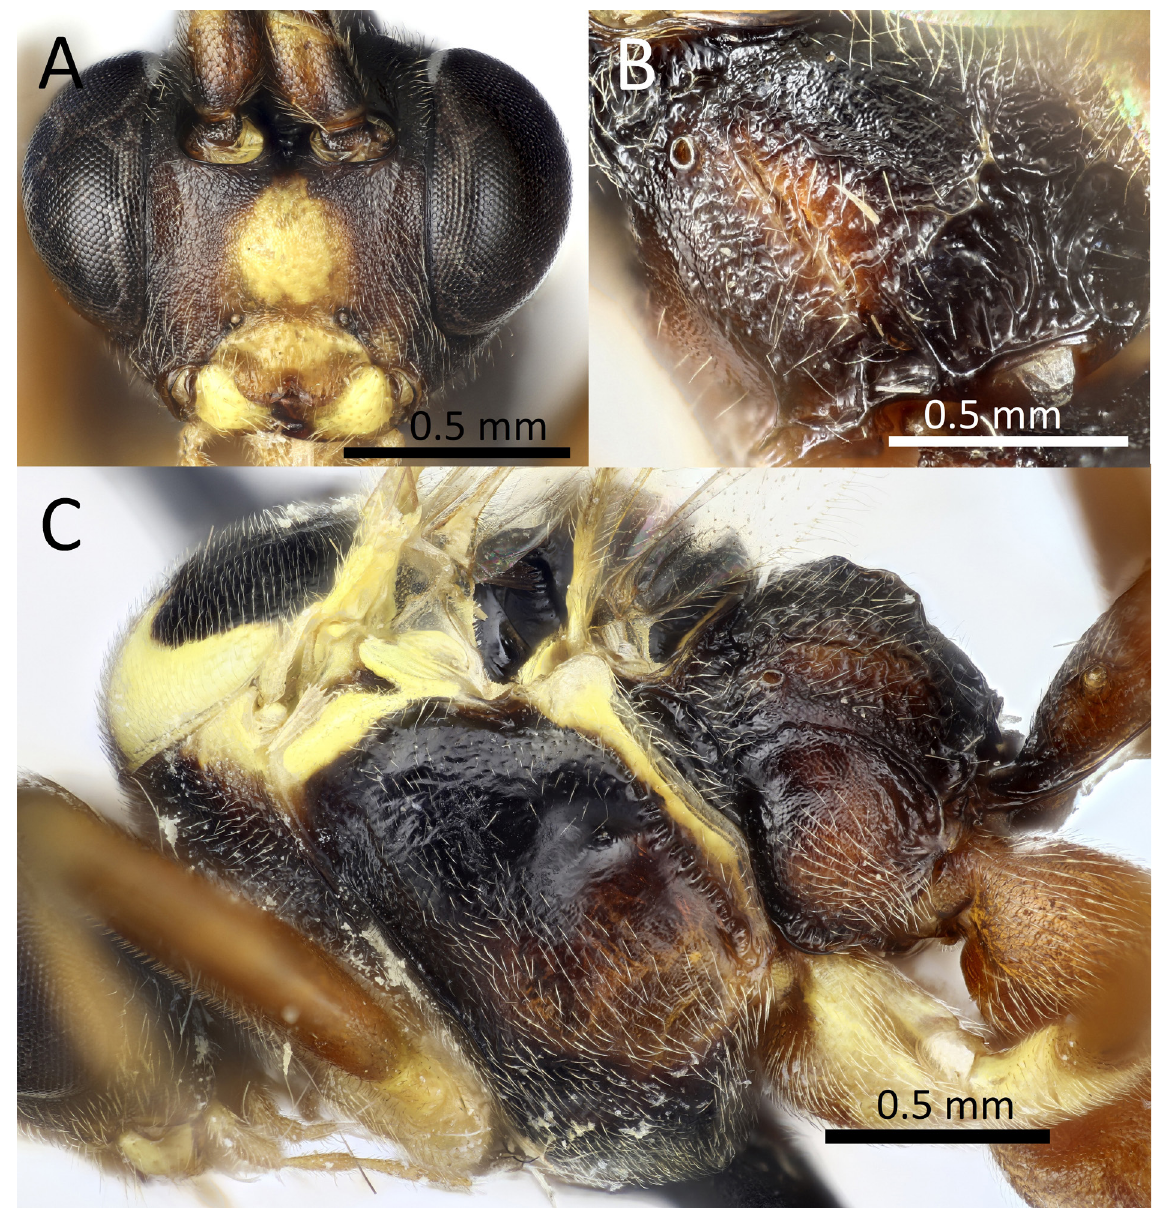
Fig. 8. Homotropus riedeli sp. nov., holotype, ♀ (NHRS-HEVA000011630). A . Head, anterior view. B . Propodeum, posterodorsal view. C . Mesosoma, lateral